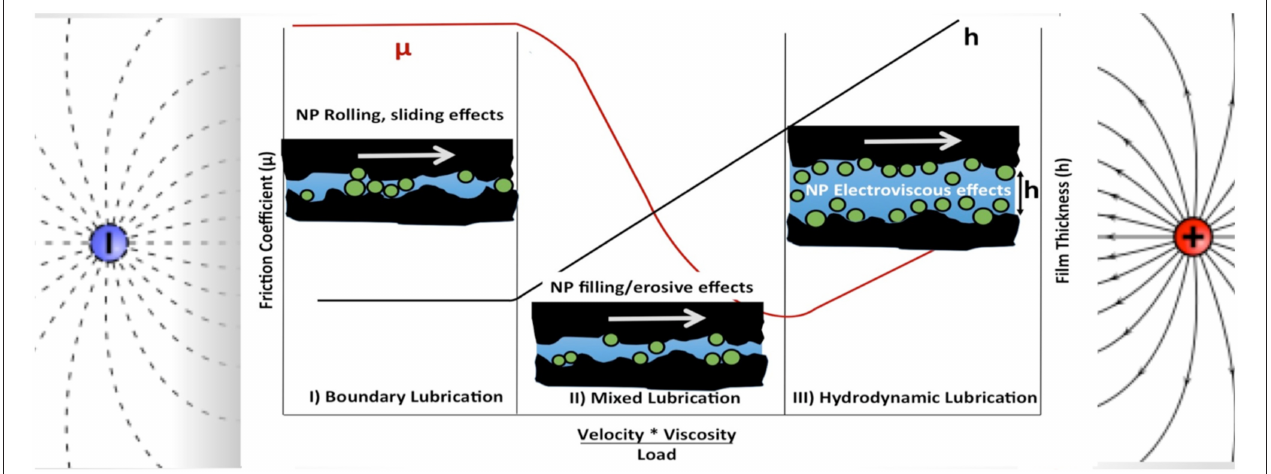
FIGURE 1 | Schematic of a Stribeck curve for a lubricated contact in the presence of an external field. [Adapted from Curtis et al. (2017)], and licensed with permission from Creative Commons 4.0 (http://creativecommons.org/licenses/by/4.0) An applied field can be employed to tune the properties of the lubricant, to additives or nanoparticles within the lubricant, to boundary layers that form between the wall and the lubricant and/or to the solid-solid contacting